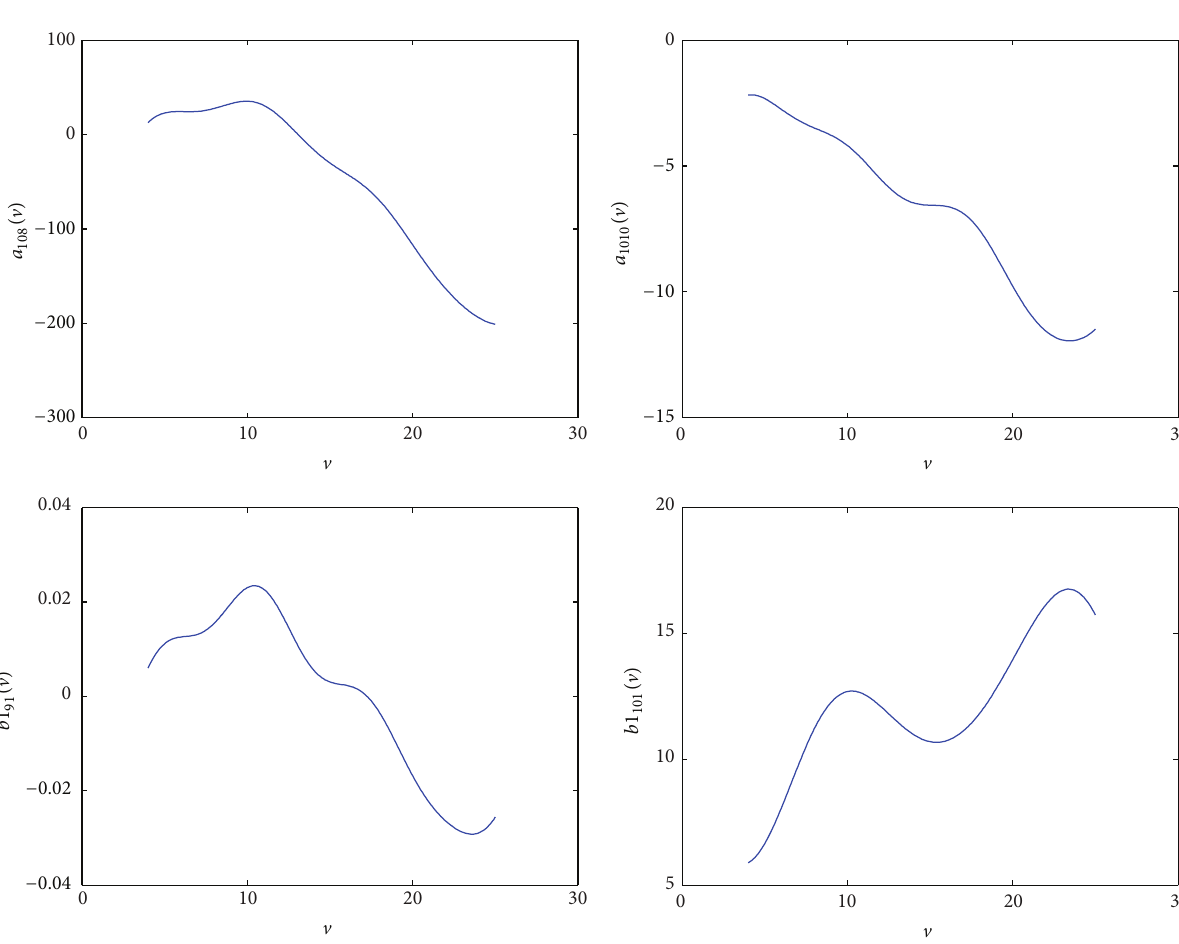
Figure 7: Nonlinear regress functions of the major varying elements.